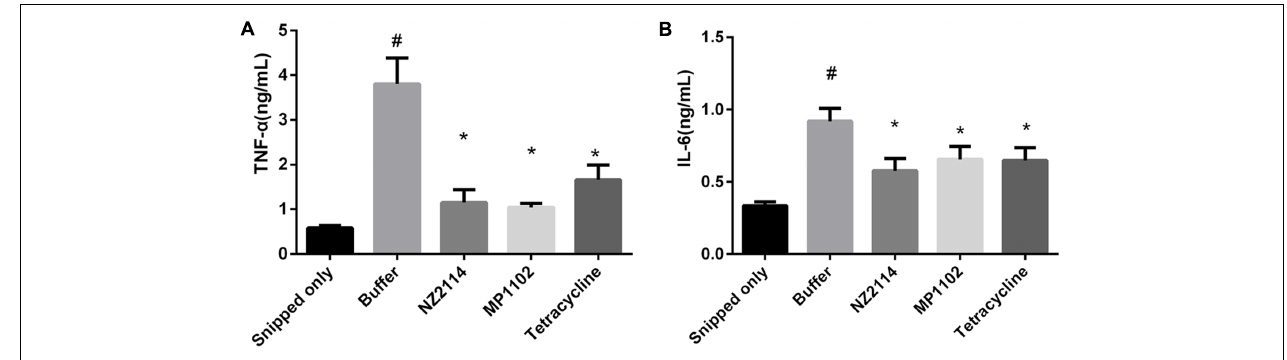
FIGURE 6 | Effects of antimicrobials on intramammary (A) TNF- α and (B) IL-6 concentrations. An asterisk ( ∗ ) demonstrates a significant difference ( P < 0.05) versus the buffer group. The symbol # demonstrates a significant difference ( P < 0.05) versus the snipped only group. Each value represents the mean ± SD.